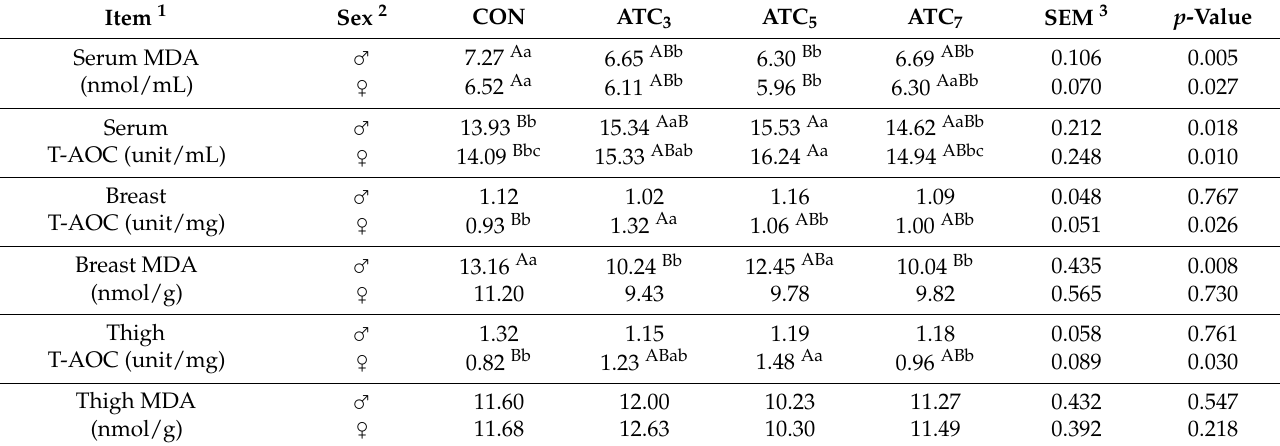
Table 6. The effects of ATC on the antioxidation indexes of geese ( n =